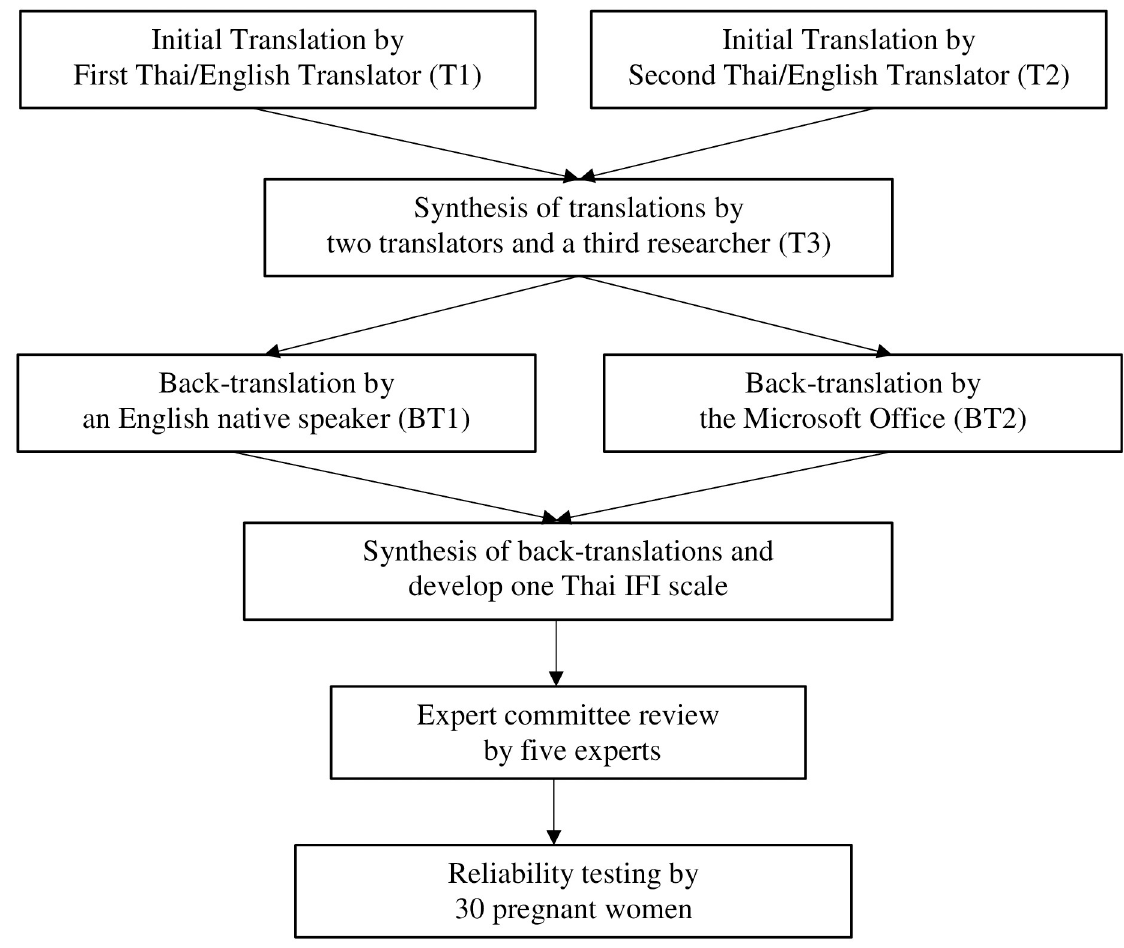
Fig 1. Flowchart of the translation